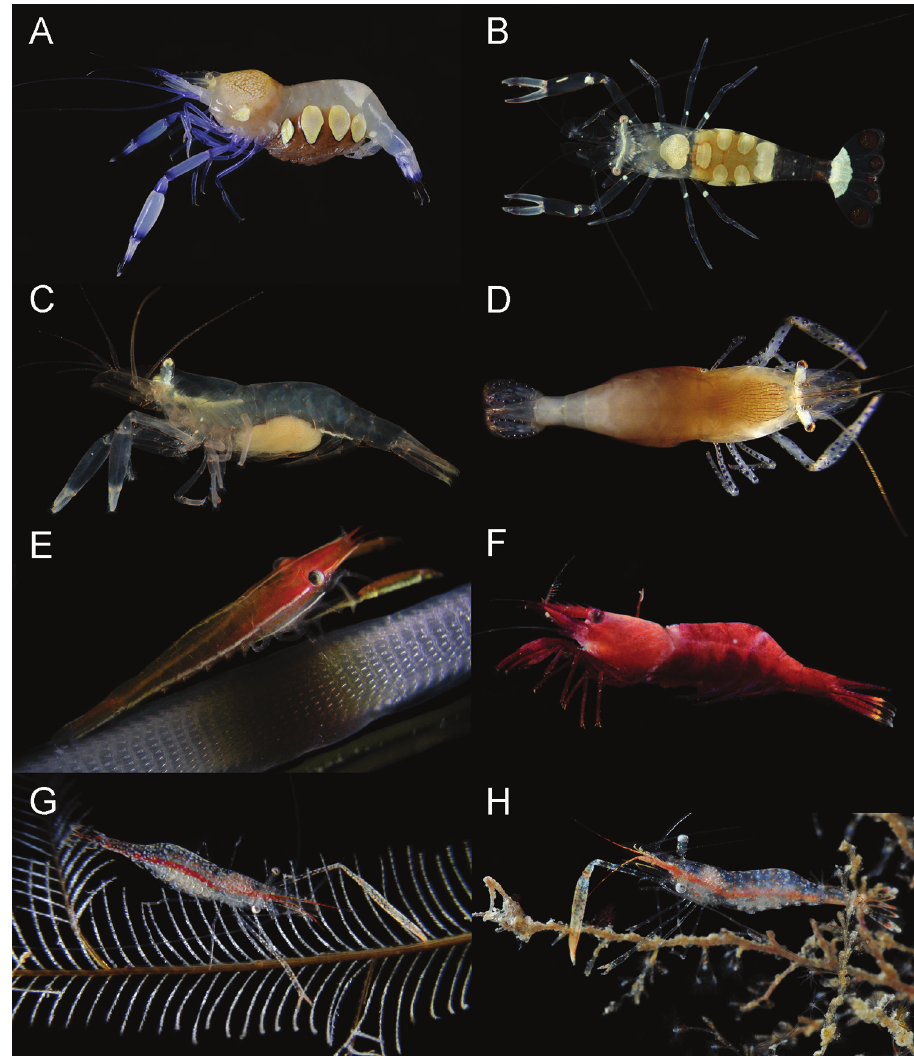
Figure 3. Examples of species from the genera reported in this study. A, B Ancylocaris brevicarpalis Schenkel, 1902: ovigerous females, MNHN-2014-558 and -156 (resp.), Kavieng, Papua New Guinea C Actinimenes inornatus (Kemp, 1922), comb. n., MNHN-IU-2014-315, with bopyrid parasite, Kavieng, Papua New Guinea D Actinimenes ornatus (Bruce, 1969), comb. n., ovigerous female, UO 80-Vn08, Nhatrang Bay, Vietnam E Cristimenes cristimanus (Bruce, 1965), comb. n., UO 103-Vn08, Nhatrang Bay, Vietnam F Cristimenes commensalis (Borradaile, 1915), comb. n., MTQ 33230, Lizard Island, Great Bar- rier Ree G Rapimenes laevimanus (Ďuriš, 2010), comb. n., ovigerous female holotype, RMNH D.53129, Nhatrang Bay, Vietnam H Rapimenes granulimanus (Bruce, 1978), comb. n., ovigerous female, MNHN- IU-2013-509, Madang, Papua New Guinea. (Photos: A–G Z Ďuriš; H A